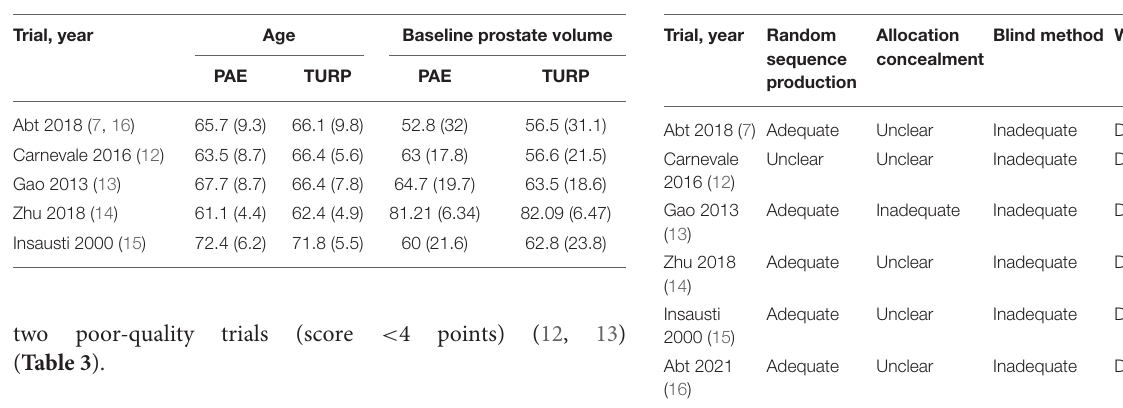
TABLE 2 | Brief overview of patients in the included trials. TABLE 3 | Assessment of randomized study